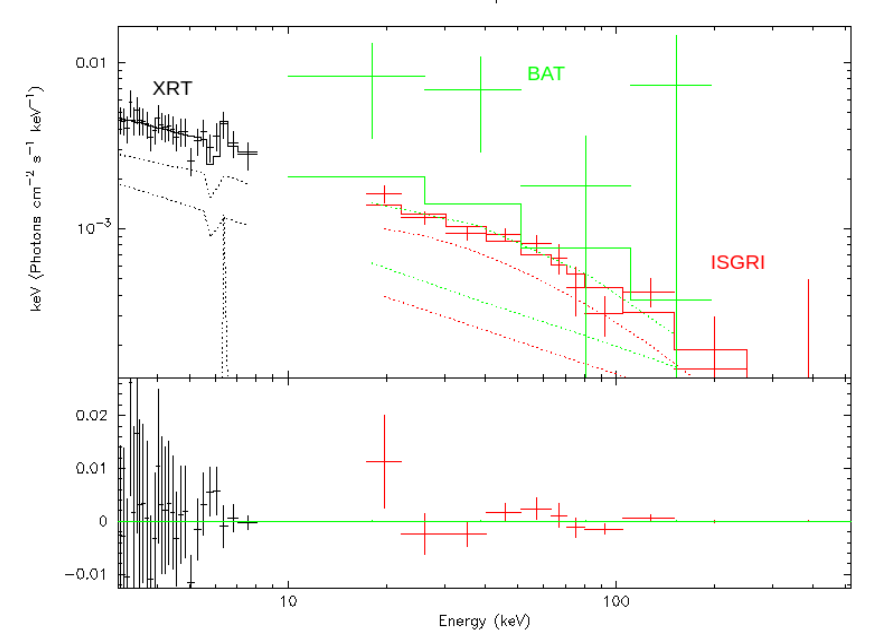
Figure A5. Unfolded SWIFT/XRT, SWIFT/BAT and INTEGRAL/ISGRI spectra of 3C 111 during 5th observational period (January 2009) and model. Above: all the spectra are shown by crosses; fitting curves are shown by solid lines; model components are shown by dotted lines; below data residuals. During this period jet base and nuclear emission components were on the same level; signs of Fe-K α emission line and absorption line near 5.9 keV are present.